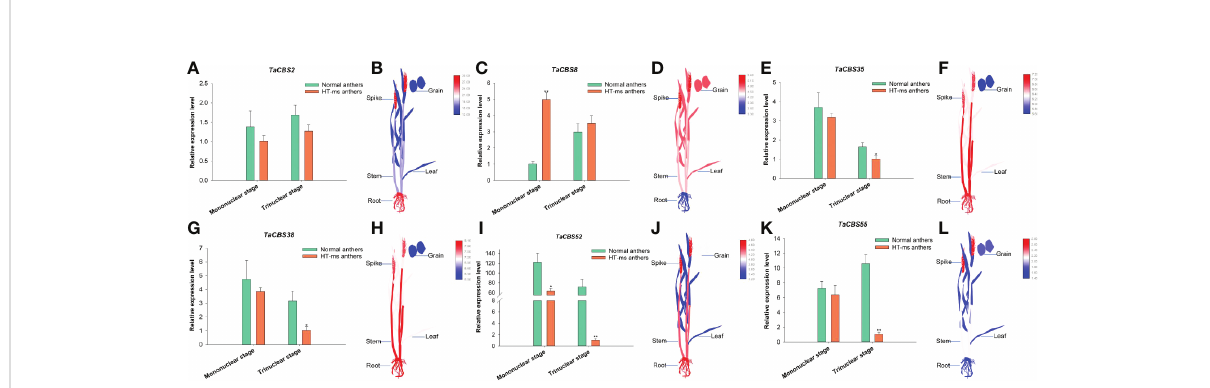
FIGURE 11 The differential expression of 6 TaCBS genes in Normal and HT-ms anther tissues by qRT-PCR ( A, C, E, G, I, and K ) and different tissues by RNA-seq data ( B, D, F, H, J, and L ). The x-axes and y-axes indicate the different stage in the Normal and HT-ms anthers and the relative gene expression levels, respectively. The electronic Fluorescent Pictograph (eFP) of wheat plant were visualized by Adobe Illustrator CS5 and TBtools. SSPS Statistics 23 software was used to analyze the data as means of three replicates ± standard error. Tukey ’ s method was used to test signi fi cantly different means between parameters based on analysis of variance (ANOVA) at 95% con fi dence levels. Capped lines indicate standard error. *P < 0.05; **P <